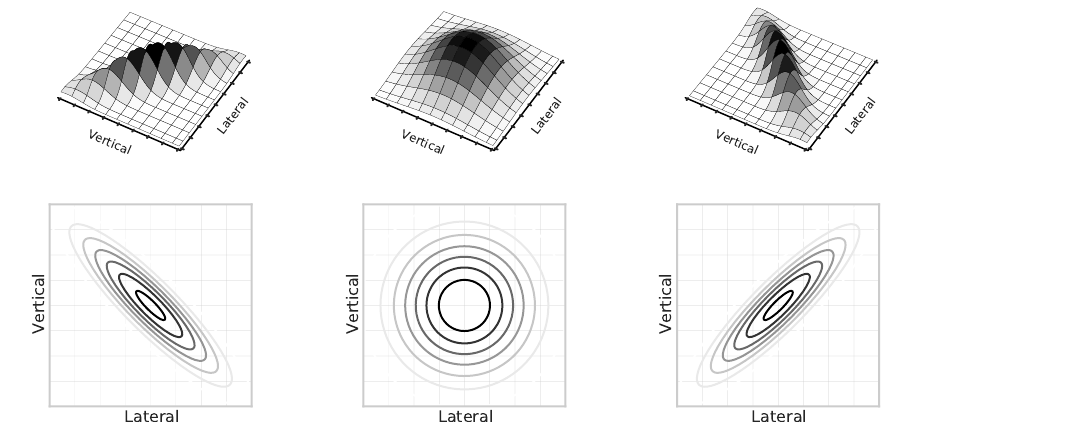
Figure 2. Example of bivariate function (Eq. 1) for equal parameters µ y , µ z , σ y , σ z , and A , but varying correlation values as ρ =− 0.9, ρ = 0, and ρ = 0.9, respectively, from left to right. Top panels represent the wake speed deficit and bottom panels the contour lines.